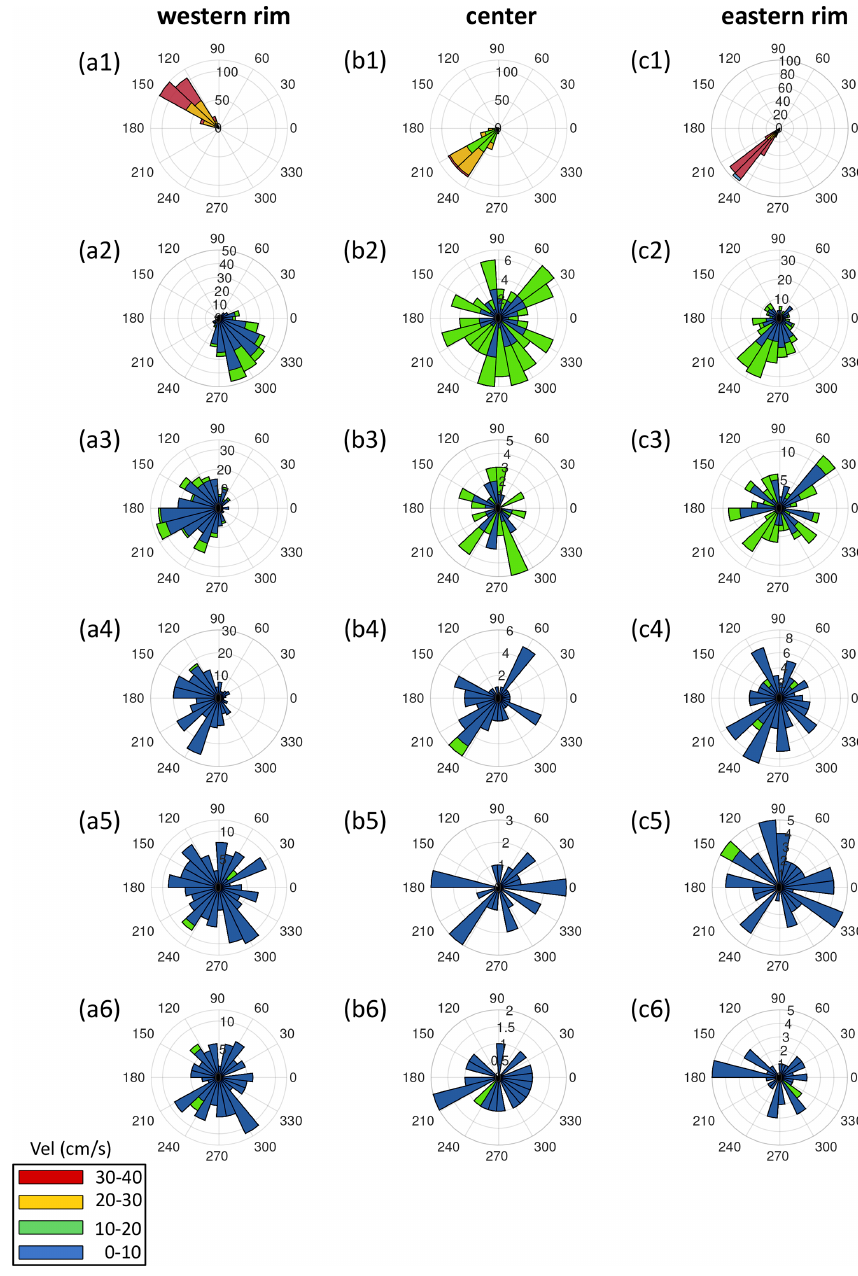
Figure 10. (a1–a6) Current velocity diagram obtained at the western rim of the eddy on 27 April. (b1–b6) Current velocity diagram obtained at the center of the eddy on 11 May. (c1–c6) Current velocity diagram obtained at the eastern rim of the eddy on 16 May. Each row from top to bottom shows the current velocity at 50, 150, 250, 500, 1000, and 1500m water depth. Different colors correspond to the distinct current velocities indicated in the